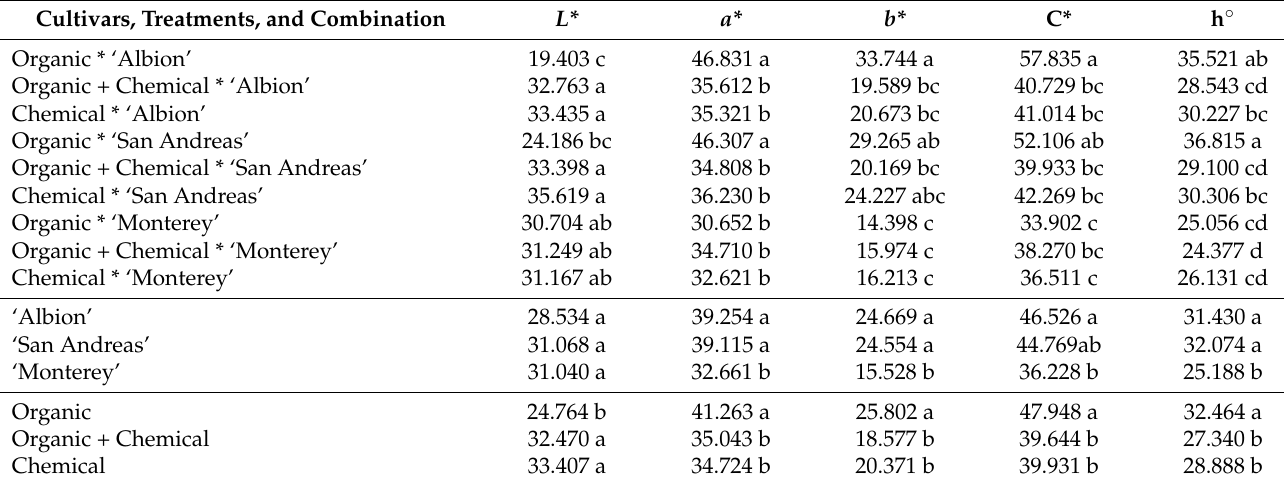
Table 2. Color values of strawberry fruits as affected by different fertilizer